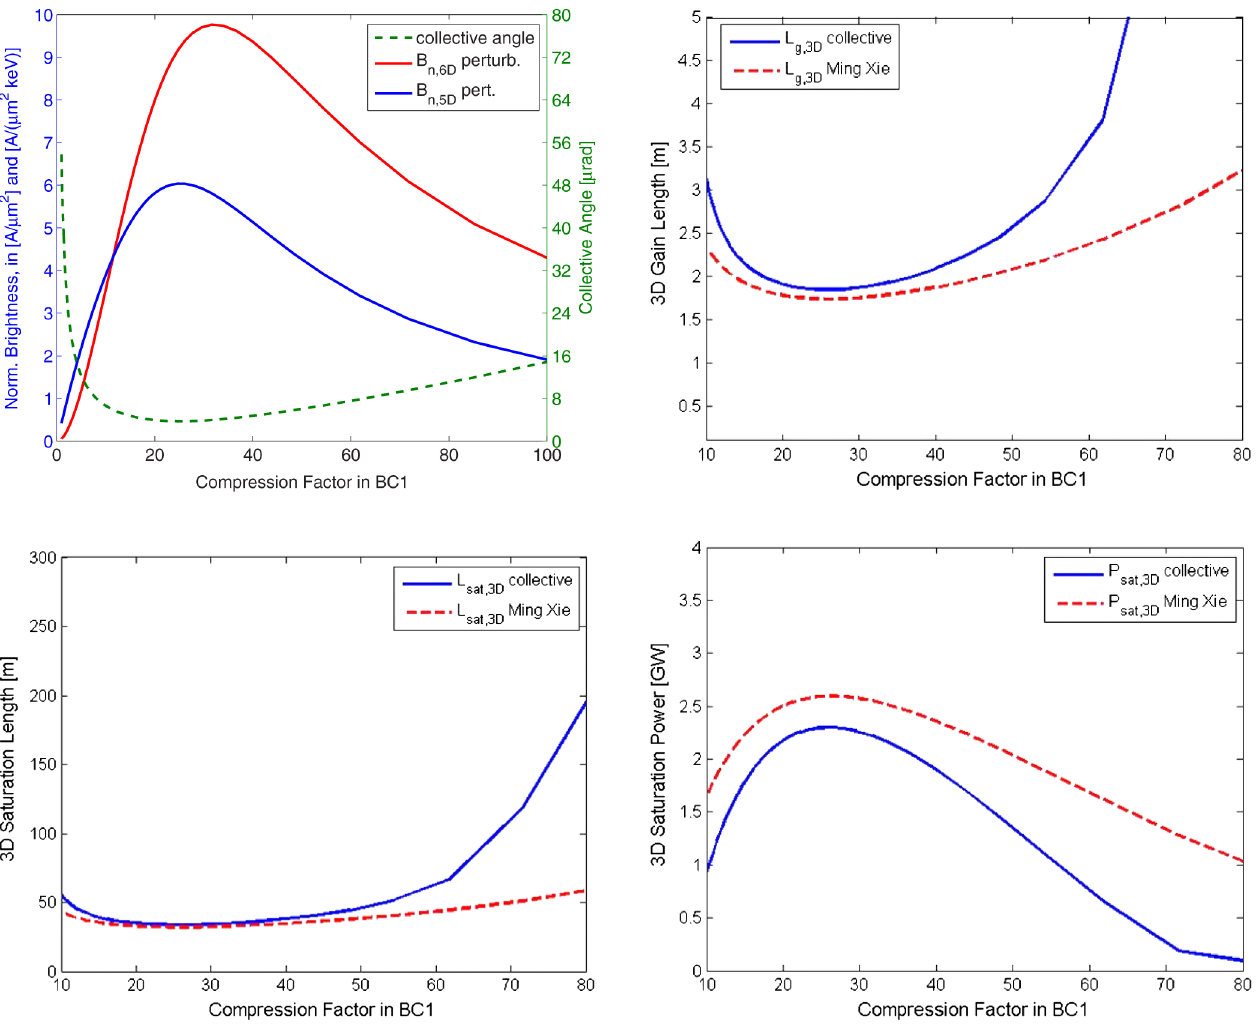
FIG. 10. Final 5D and 6D normalized brightness and collective angle [Eq. (2)] vs compression factor in BC 1 (top left panel) for a 50 pC bunch charge accelerated in XL with two-stage compression; the total compression factor is set at 100 and the final peak current is 1 kA. The 3D gain length (top right), 3D SASE saturation length (bottom left), and 3D SASE saturation power are evaluated in the Xie sense and in the presence of collective effects,